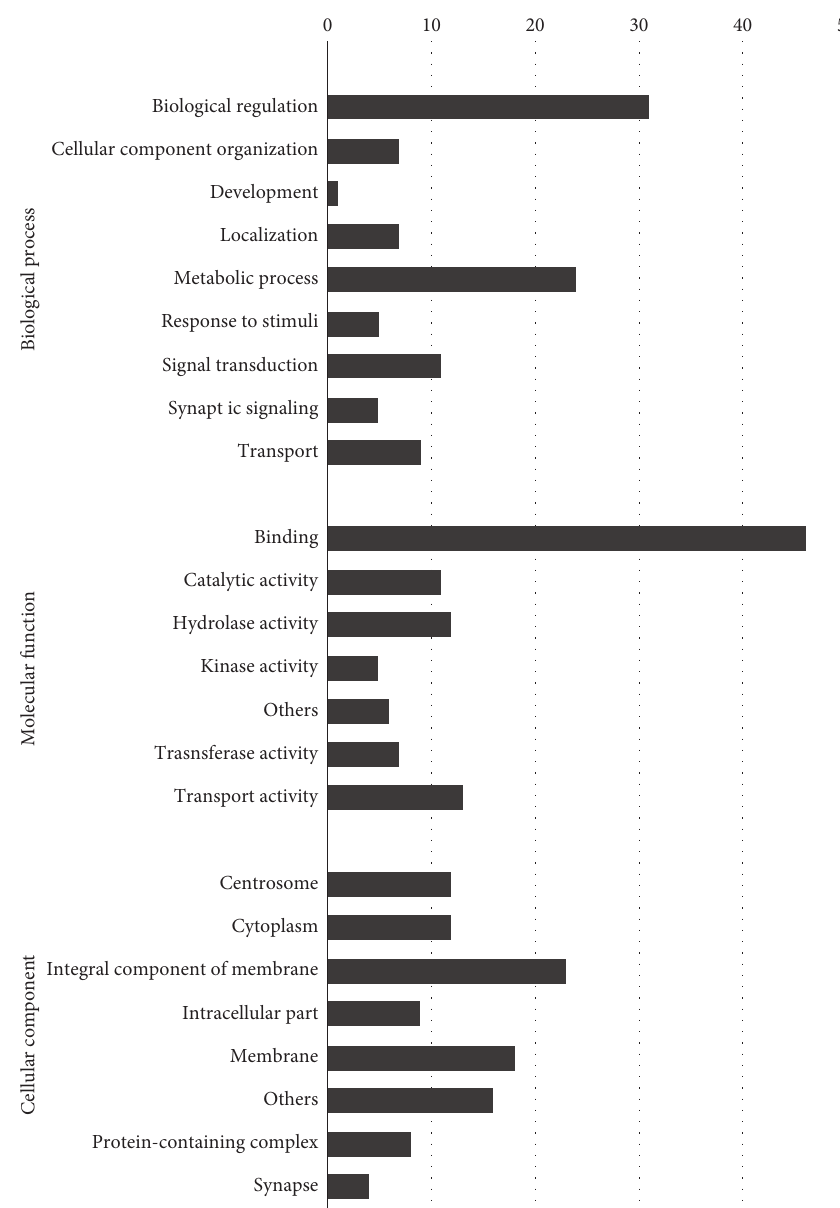
Figure 3: Percentage representation of gene ontology (GO) enrichment analysis of lncRNA targets in S. mansoni